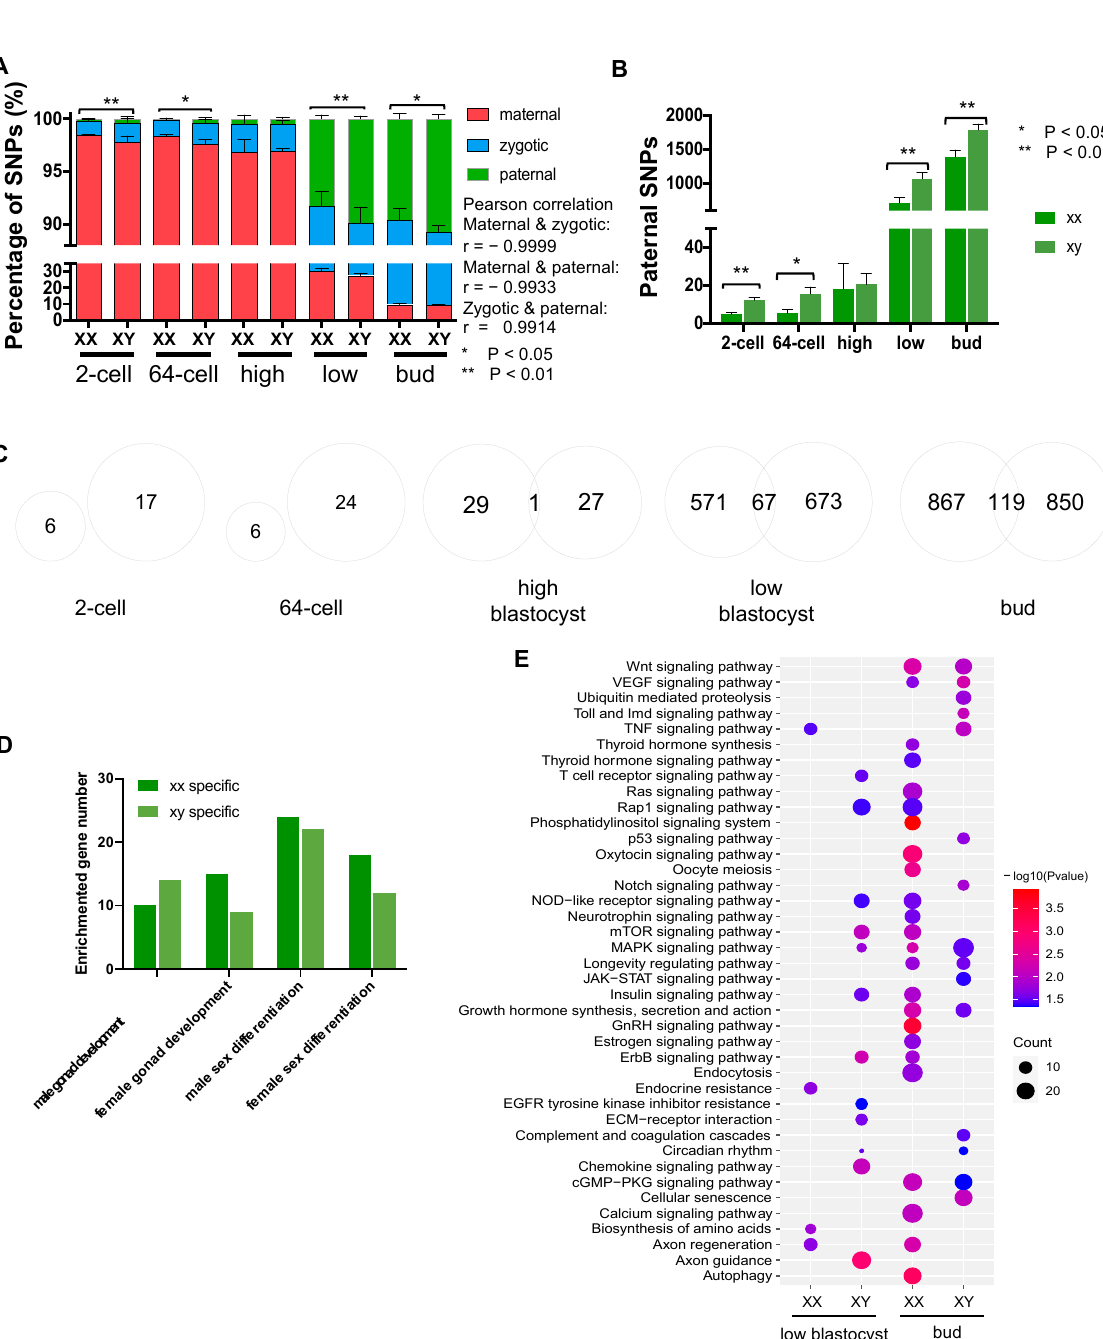
Figure 7. Dissecting contributions of paternal inheritance to sexual dimorphism of yellow catfish through identification of paternal SNPs and related genes from embryonic development. ( A ) Composition of maternal, zygotic, and paternal SNPs (by percentage) at each stage of embryonic development. ( B ) Paternal SNPs of female and male embryos at each stage. ( C ) Overlap of paternal genes at each stage. ( D ) Gonad development and sex differentiation genes in female and male embryos. ( E ) Pathways of female and male-specific paternal genes enriched in different sexes at low-blastocyst and bud stages are grouped respectively.